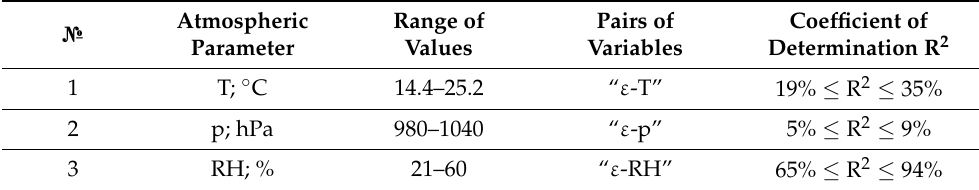
Figure 8. Correlation between the permittivity ε of PU SikaBlock ® -M150 foams (density of 144 kg/m 3 ) and the relative humidity RH of atmosphere in the test room at frequencies f 3 = 40 Hz (beige), f 8 = 1280 Hz (green), and f 14 = 81,920 Hz (black). By comparing the R 2 values, the best correlation was identified between the PU foams permittivity and the relative humidity (0.63 ≤ R 2 ≤ 0.93), as shown in Table 2. The correlation with temperature was small (0.19 ≤ R 2 ≤ 0.35) and practically no correlation with pressure was revealed (0.08 ≤ R 2 ≤ 0.09). Table 2 . Correlation between the permittivity and atmospheric parameters in the short series.